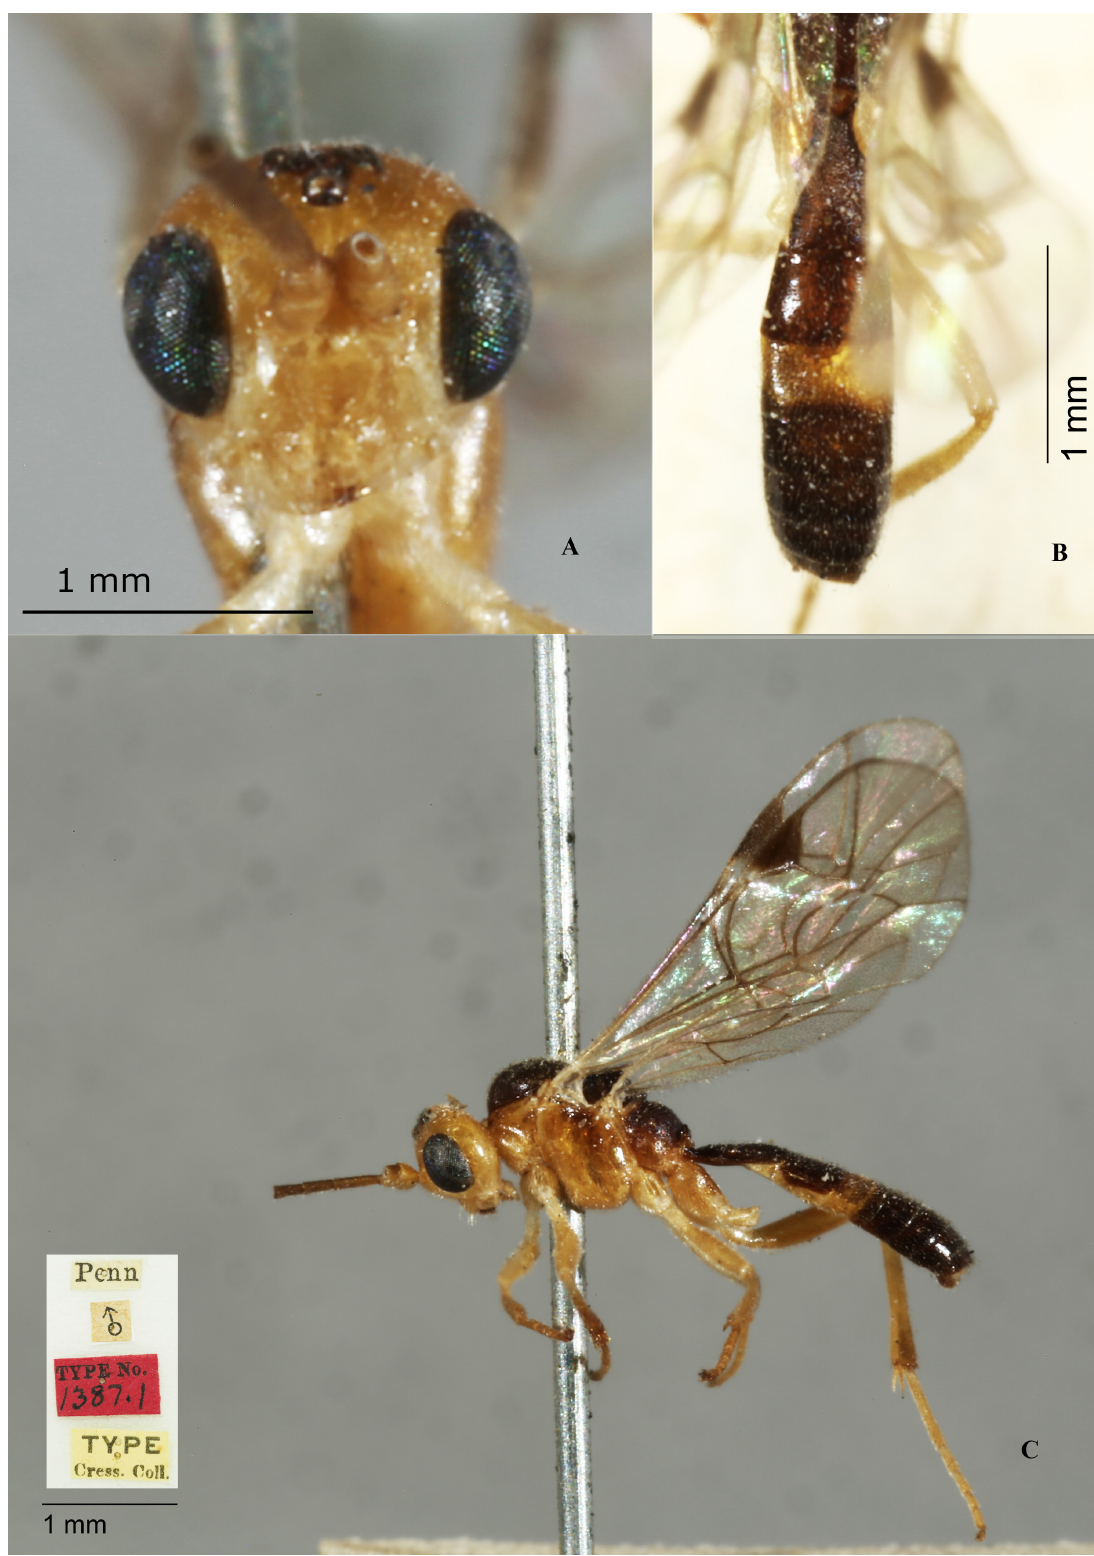
Fig. 2 . Nanium capitatum Townes, 1967, lectotype, ♂ (ANSP). A . Face. B . Metasoma (dorsal view). C .